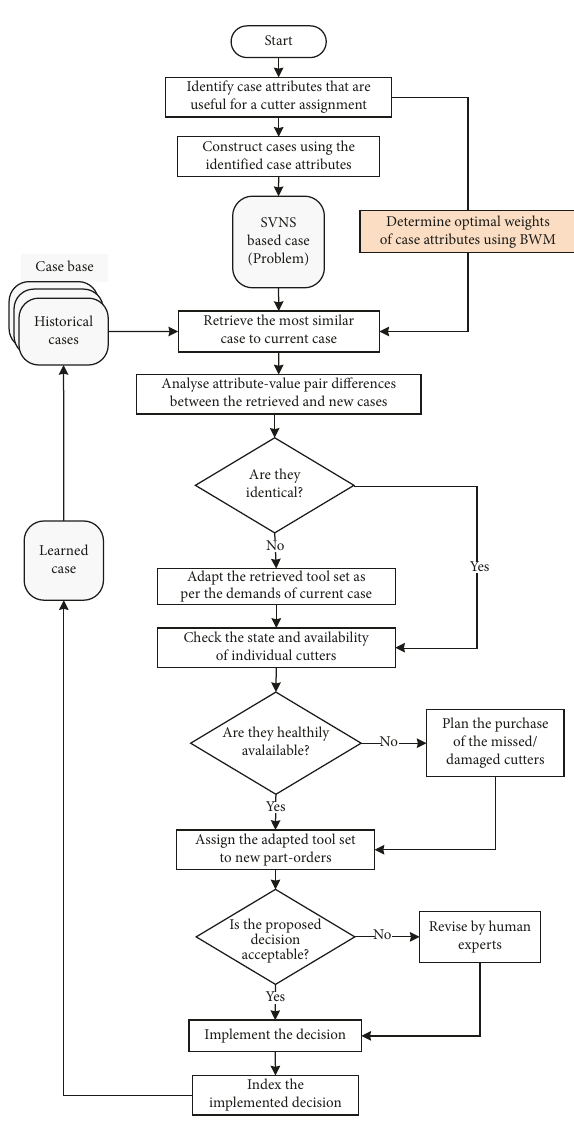
Figure 2: Methodological approach of the proposed DSS (adapted from